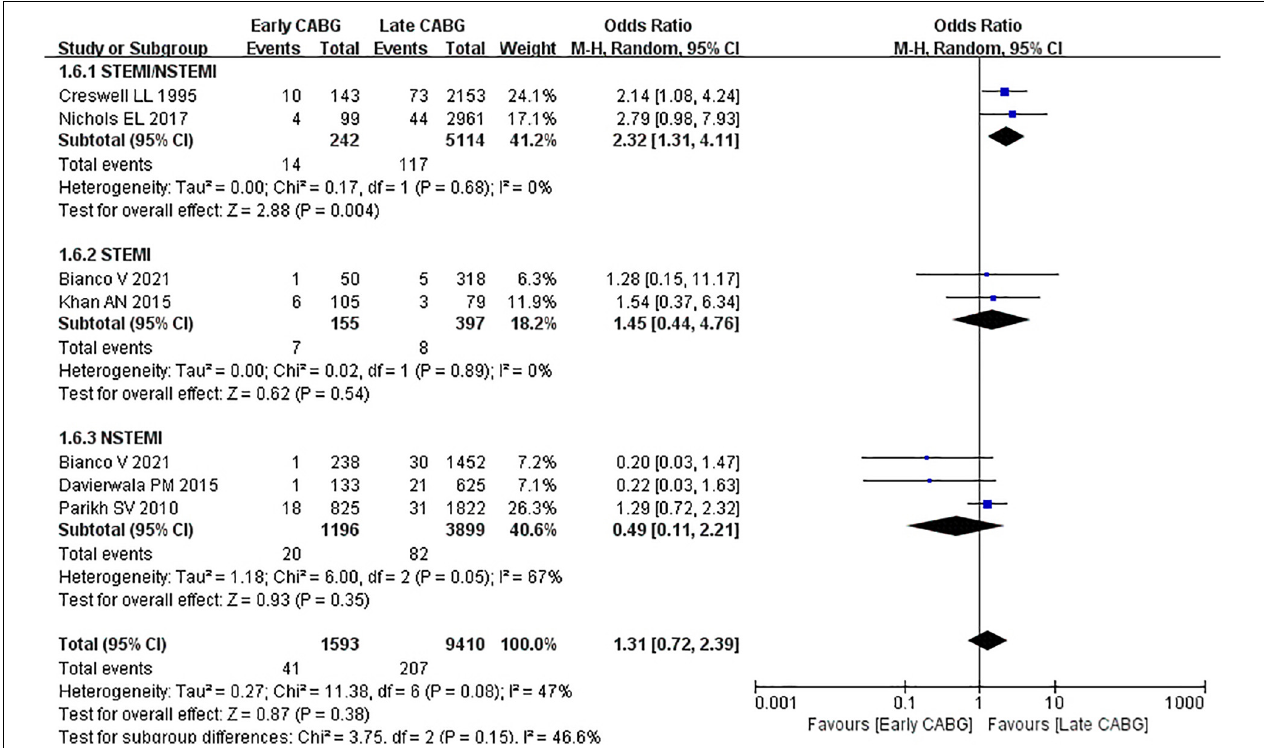
FIGURE 6 | Cerebrovascular accident in early CABG groups vs. late CABG